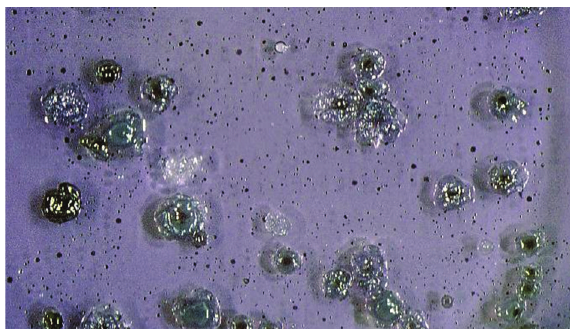
Figure 1: Streptococcal colonies appeared from saliva of an ABD patient in MS agar dish. According to the instruction of the MS agar (Difco Lab.), mainly 3 kinds of bacterial colonies are di ff erentiated as blue crystal (probably S. mitis, etc.), gum-drop ( S. salivarius, etc.), and dip (micrococcus species, etc.) shapes at 3–5 day